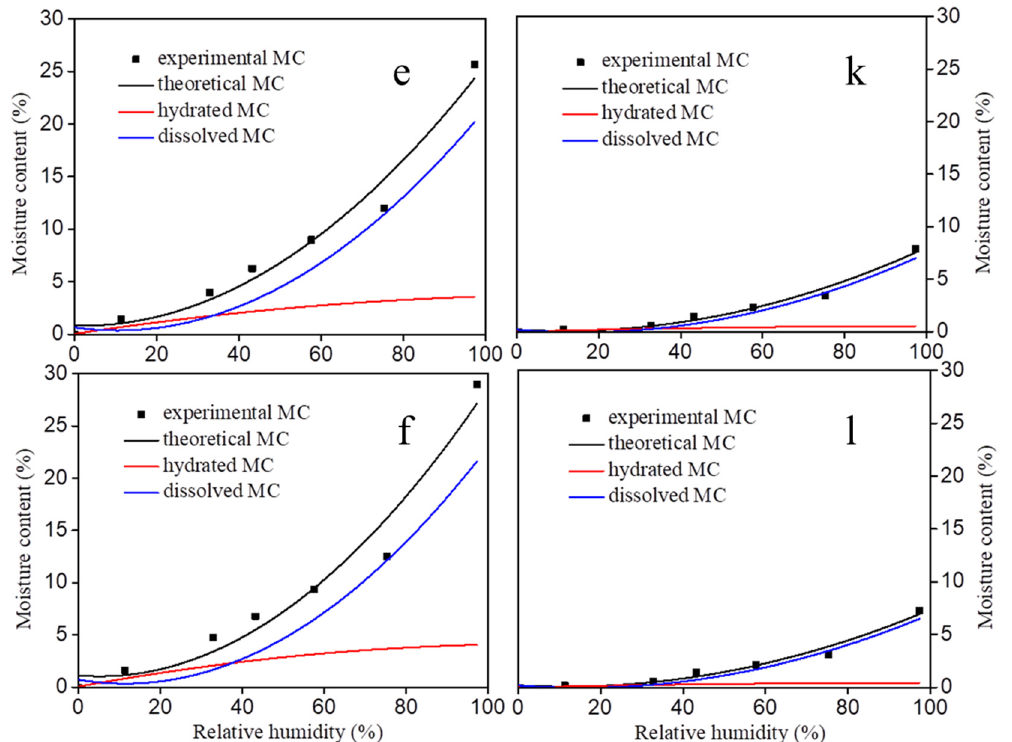
Figure 3. Hydrated, dissolved moisture content (MC) calculated with the Hailwood–Horrobin model and the sum of hydrated and dissolved (theoretical) adsorption isotherms through the relative humidity run compared to the experimental MC of DW ( a – f ) and PMMA/DW ( g – l ).